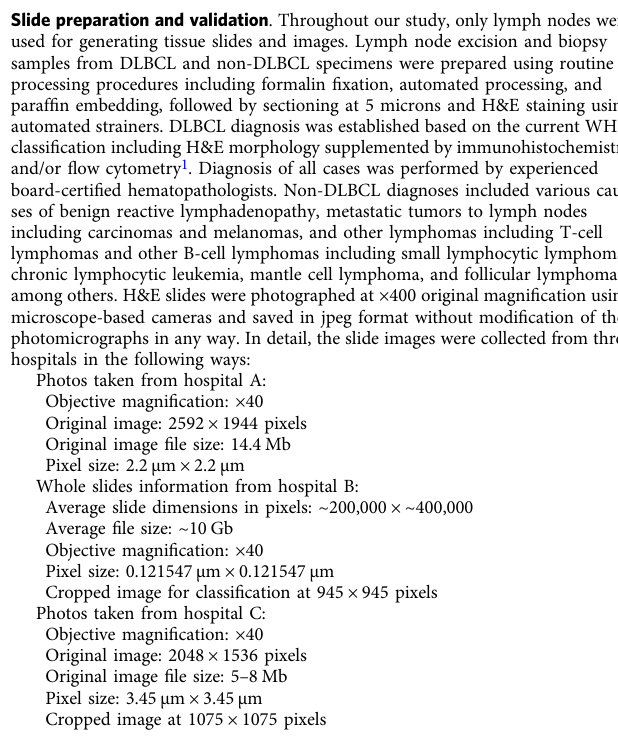
for data loading, data augmentation, network architectures, loss functions, and evaluation metrics that are tailored for the char- acteristics of medical image analysis and computer-assisted intervention.